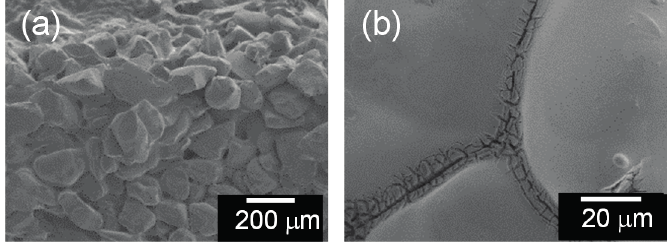
Figure 2. FE-SEM images of the TiO 2 -coated partially sintered glass with ( a ) low and ( b ) high